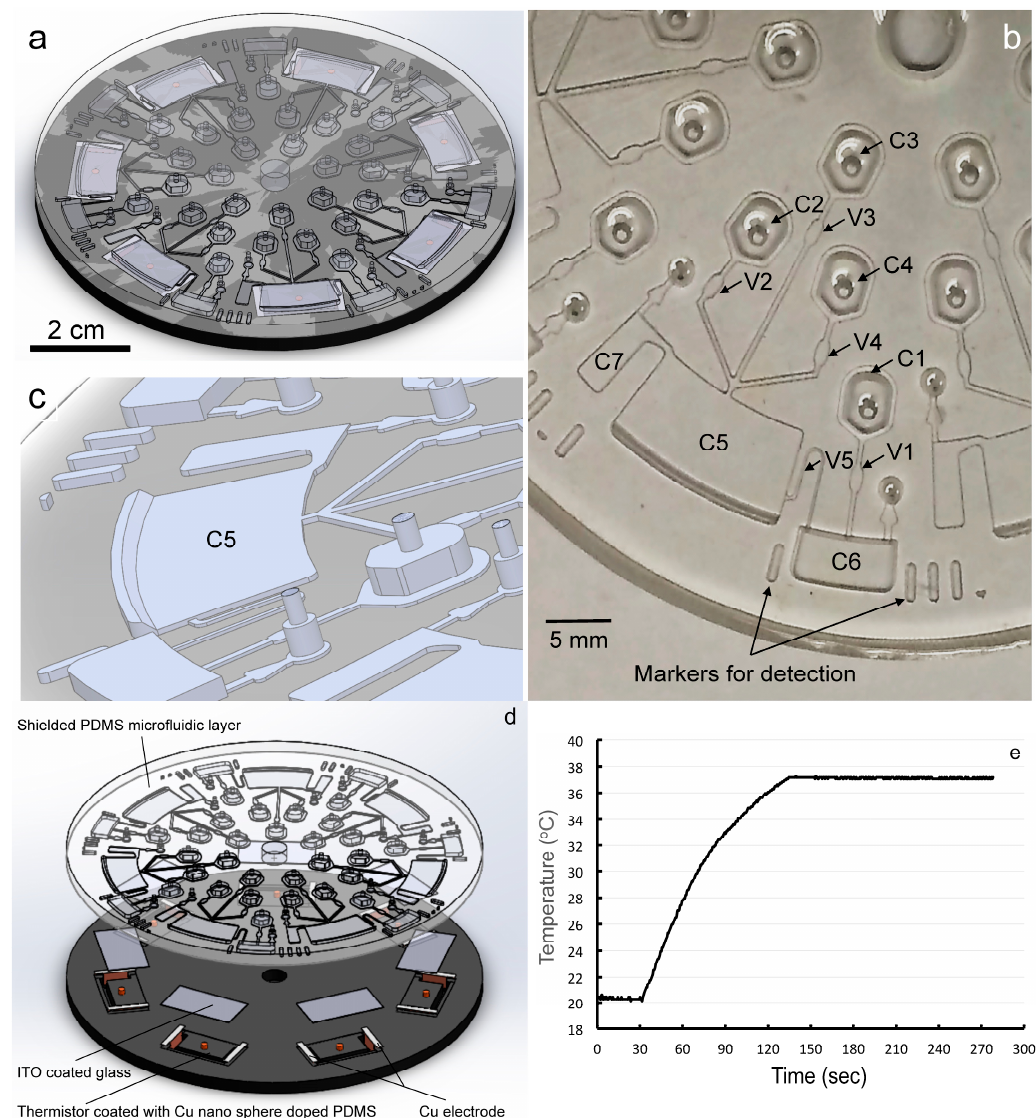
Figure 4. The next generation LOAD for testing allergy. A schematic diagram showing the layout of the LOAD with 7 identical units ( a ); arrangement of chambers, channels, valves and siphon in one unit for testing allergy ( b ); a zoom-in diagram showing the flange in C5 ( c ); assembly of the integrated microfluidic layers with ITO-glass microheaters, electrodes and thermistors is given in panel ( d ); a typical temperature profile in one reaction chamber of the LOAD using an ITO microheater to control temperature at 37 °C ( e ).